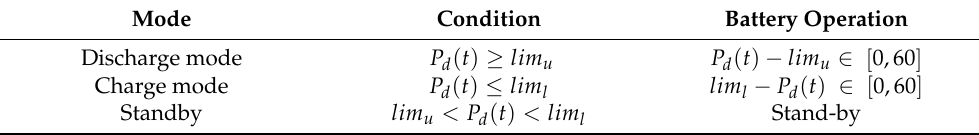
Table 2. Dansmästaren’s BESS peak shaving